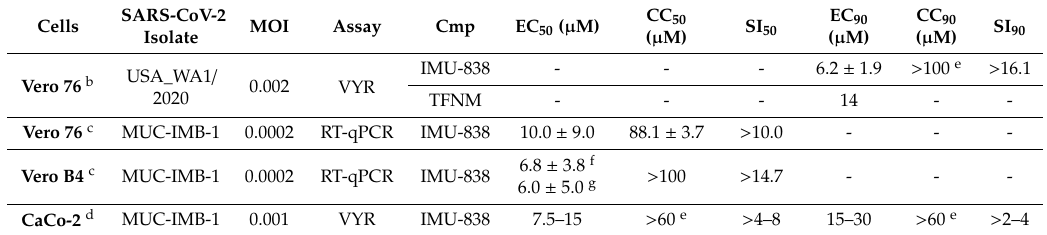
Table 1. Overview of IMU-838 e ffi cacy in cultured-cell-based SARS-CoV-2 infection models.